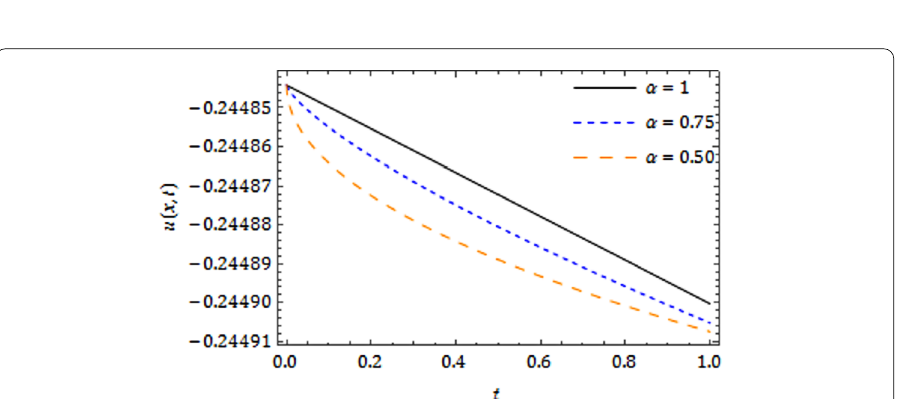
Figure 3 Nature of u ( x , t ) with t for Example 6.1 at ω = 0.005, (cid:2) = –1, (cid:13) = 0.1, c = 10, x = 1 and n = 1 with diverse